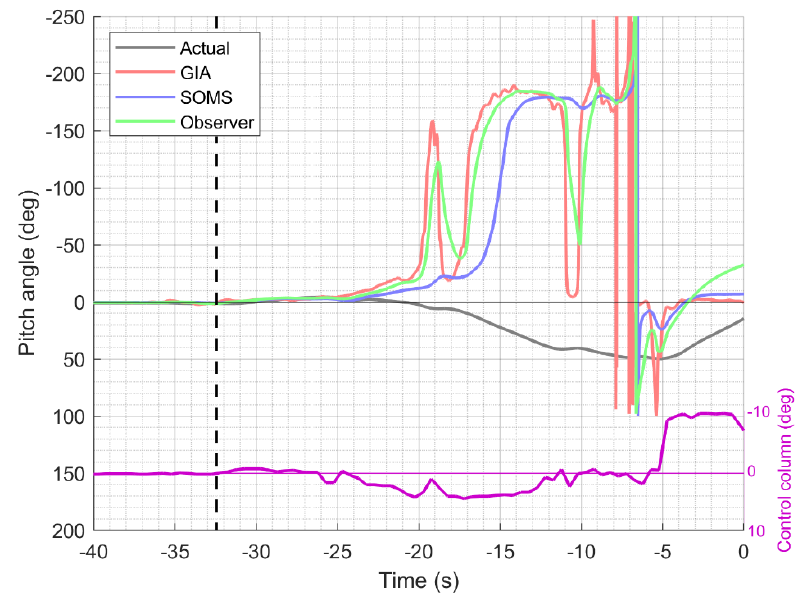
Figure 3. Time histories of the actual pitch angle (black), the computed GIA (red), and the perceived pitch predicted by the SOMS model (blue) and the Observer model (green), respectively. Note that the corresponding y-axis (on the left) is shown inverted to match the common aviation reference frame in which pitch up is positive. The x-axis shows the time in seconds until the end of the flight data recording. The vertical black dashed line indicates the TO/GA activation. The bottom part of the graph shows the time history (in purple) of the control column corresponding to the y-axis shown on the right (in degrees; positive is push down).